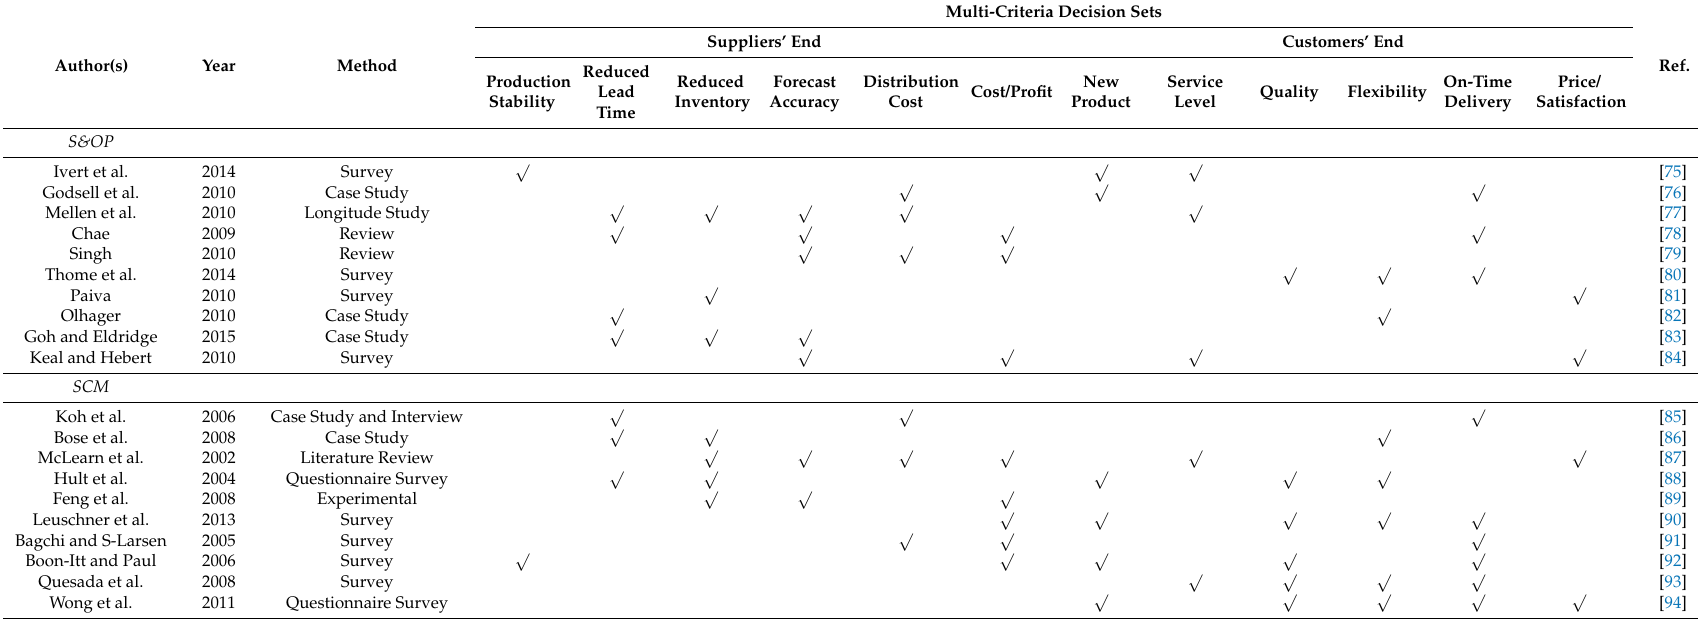
Table 2. Multi-criteria decision sets for sales and operation planning (S&OP) and Extended Supply chain